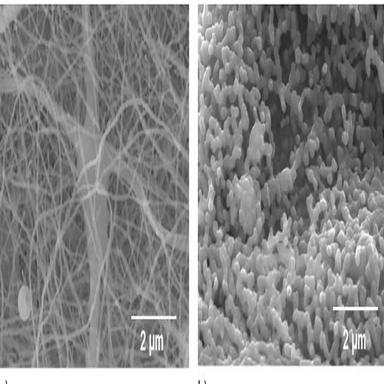
SEM micrographs (SE-mode) of the 3Y–Zr fibers sintered with a heating rate of 10 K/min a) 1100 °C and b) 1350 °C.